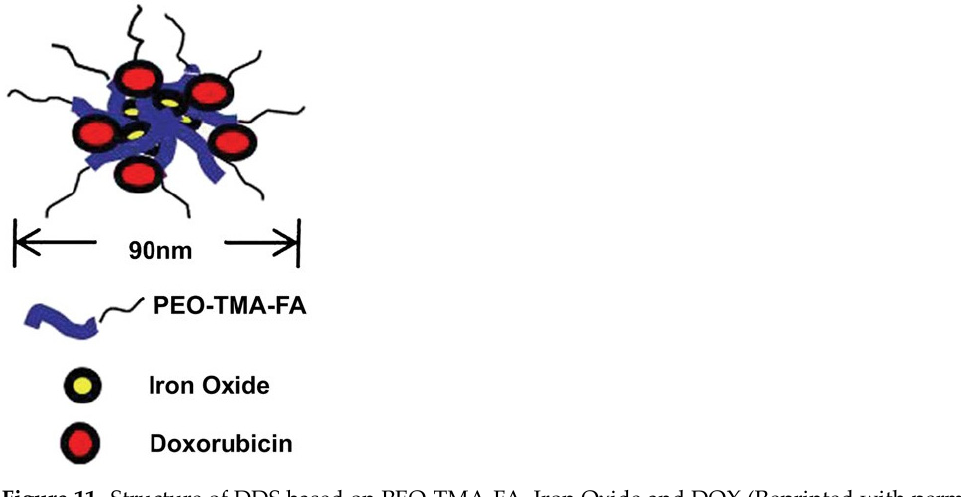
Figure 11. Structure of DDS based on PEO-TMA-FA, Iron Oxide and DOX (Reprinted with permis- sion from Ref. [76]. 2010, Jin Hee).